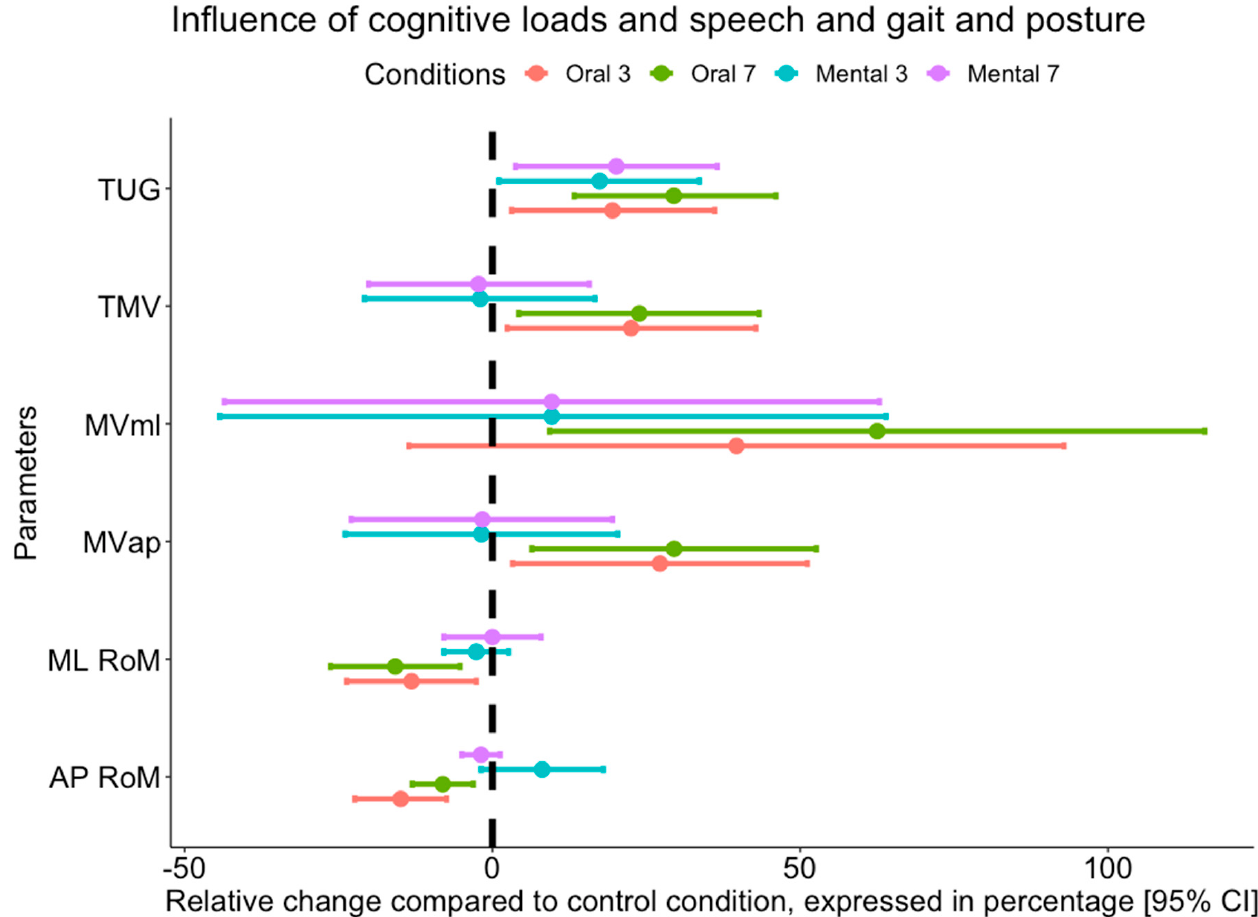
Figure 2. Influence of the different modalities on gait (TUG) and balance-related parameters.